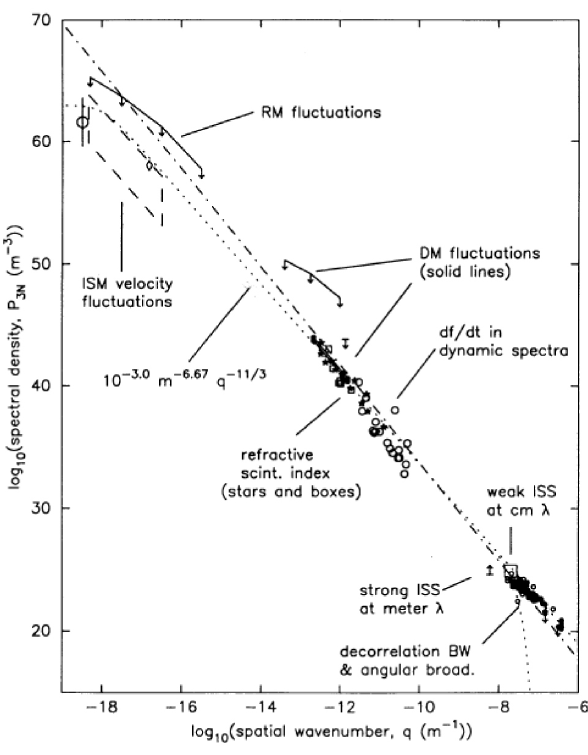
Fig. 3. Power spectrum of density along the line of sight from different data sets, and the dashed line as a reference for a Kolmogorov-like spectrum for one dimension ( k − 11 / 3 ) (extracted from Armstrong et al.,